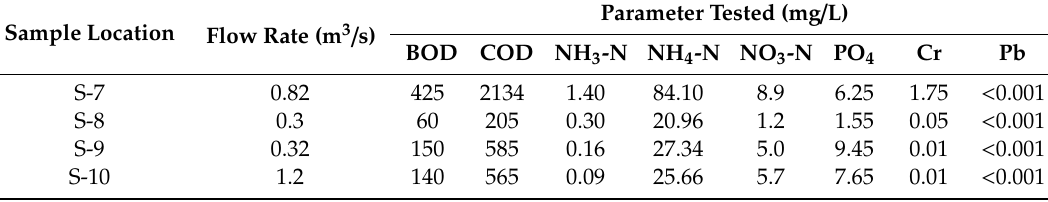
Table 4. Wastewater pollutant in four outlets.